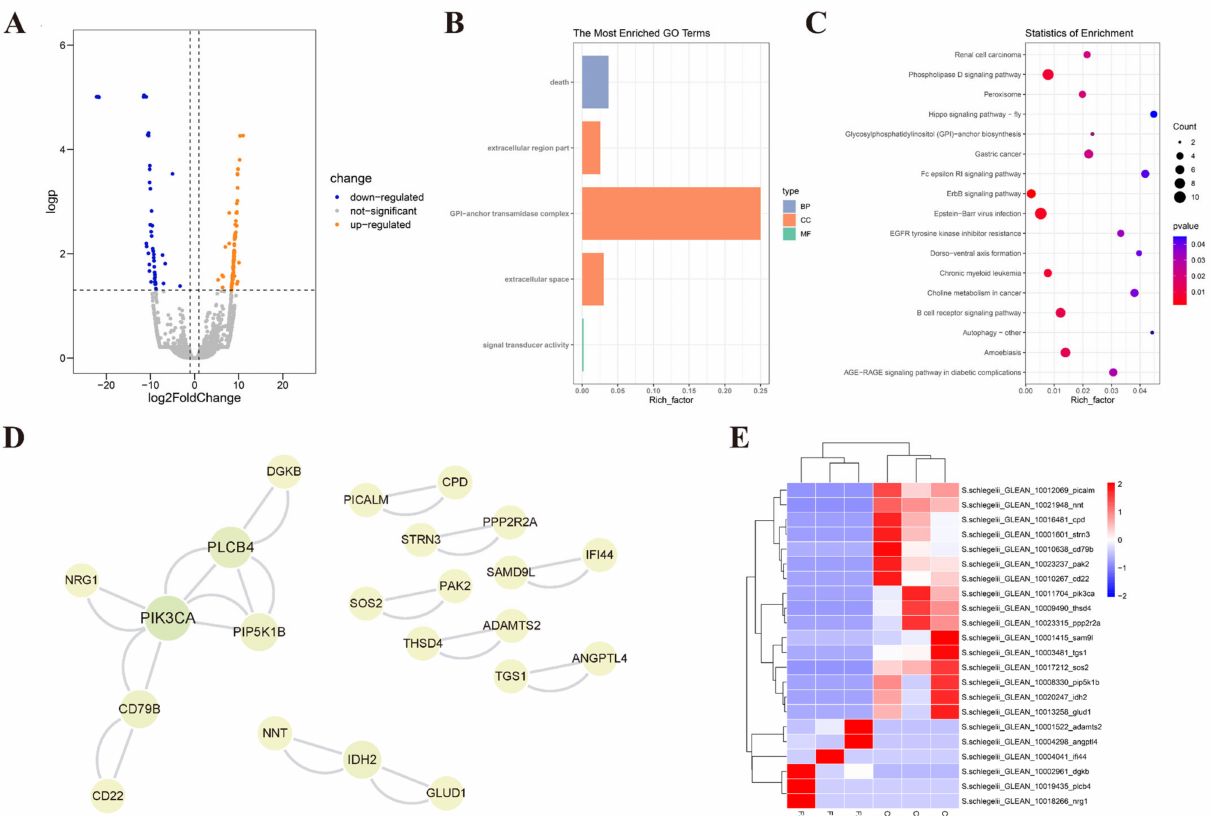
Figure 4. Transcriptome analysis of sperm with the cryodiluent (FBS + 15% Gly). ( A ) DEGs in transcriptome profile of cryopreserved sperm. One hundred seventy-nine DEGs were identified, including 97 upregulated genes and 82 downregulated genes. ( B ) GO enrichment analysis of DEGs. Statistical significance was accepted when p < 0.05. ( C ) KEGG enrichment analysis of DEGs. Statistical significance was accepted when p -value < 0.05. ( D ) The PPIN of DEGs. The PPIN was constructed by STRING database and visualized using Cytoscape software. The node size is positively correlated with degree. ( E ) The expression pattern of key DEGs identified in PPIN. The x-axis shows sampled tissues, with the prefix F for sperm without cryopreservation and C for sperm with cryopreservation, and the y-axis shows genes. The color scale showed standardized RPKM values normalized by Z-score